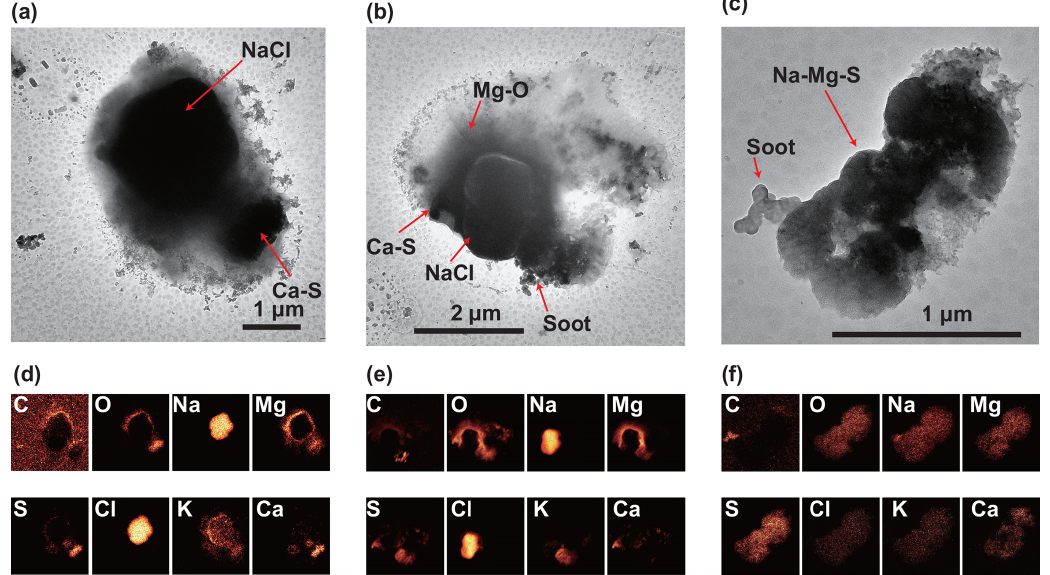
Figure 8. TEM and elemental mapping images of the sea-salt particles in a sample (10:00–10:19UTC, 30 March 2018). Top images (a–c) : TEM images of the sea-salt particles mixed with various grains. Bottom images (d–f) : elemental mapping images of the TEM areas for C, O, Na, Mg, S, Cl, K, and Ca. Soot particles are attached to the sea-salt particles in panels (b) and (c) . C-O-Mg in the particles in panels (a) and (b) occurs around NaCl